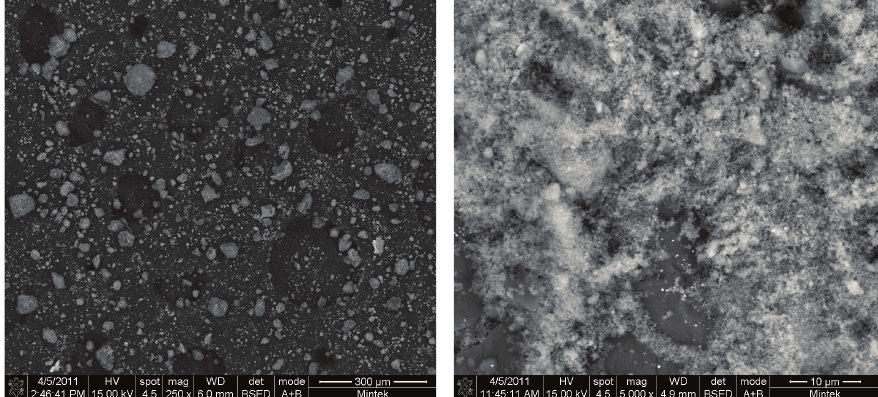
Figure 7: SEM images of the CCA/TiO 2 nanocatalysts.